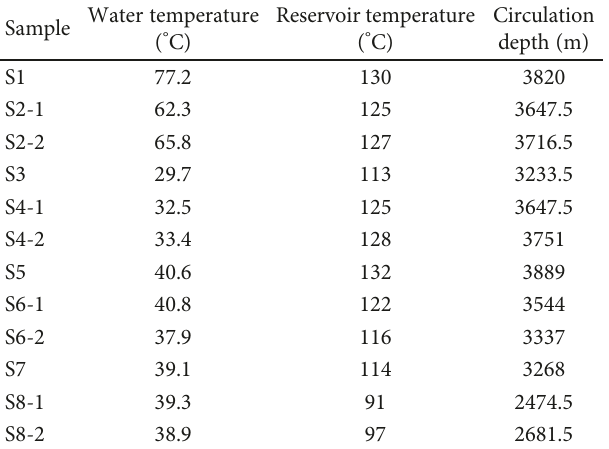
Table 4: Estimated circulation depths of the hot springs in the Simao Basin. Water temperature Sample ( °